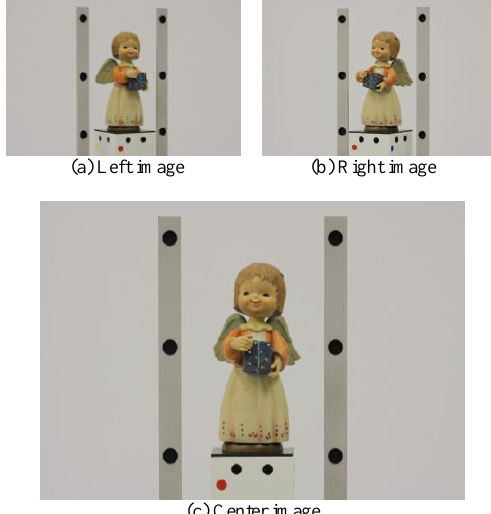
Figure 1. Proposed imaging system.